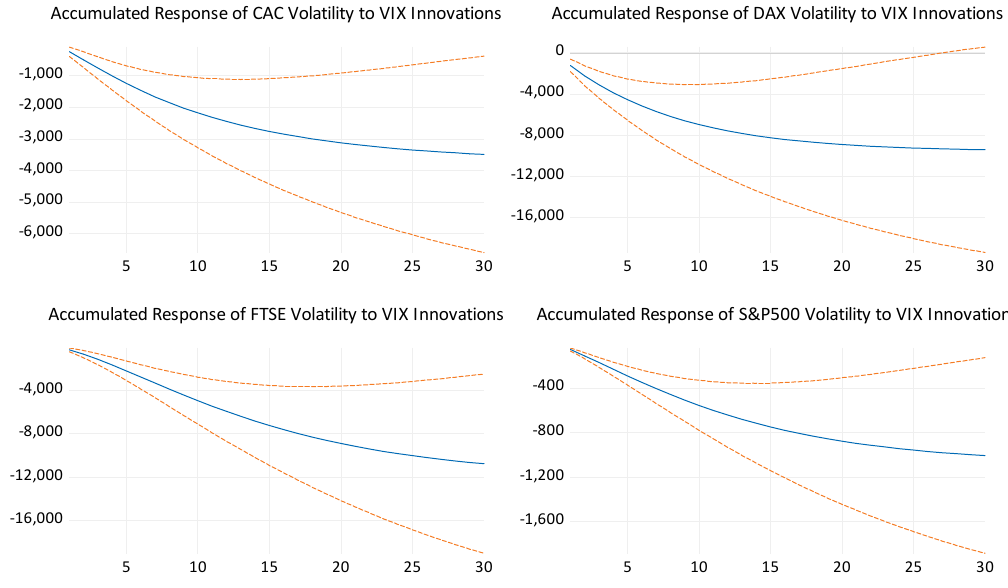
Figure 6. Responses of volatility in equity indices to structural innovations in VIX. Estimates and two standard deviation confidence band are in solid and dotted lines. SVAR lag order is one. 13 August 2015 − 17 May 2016.